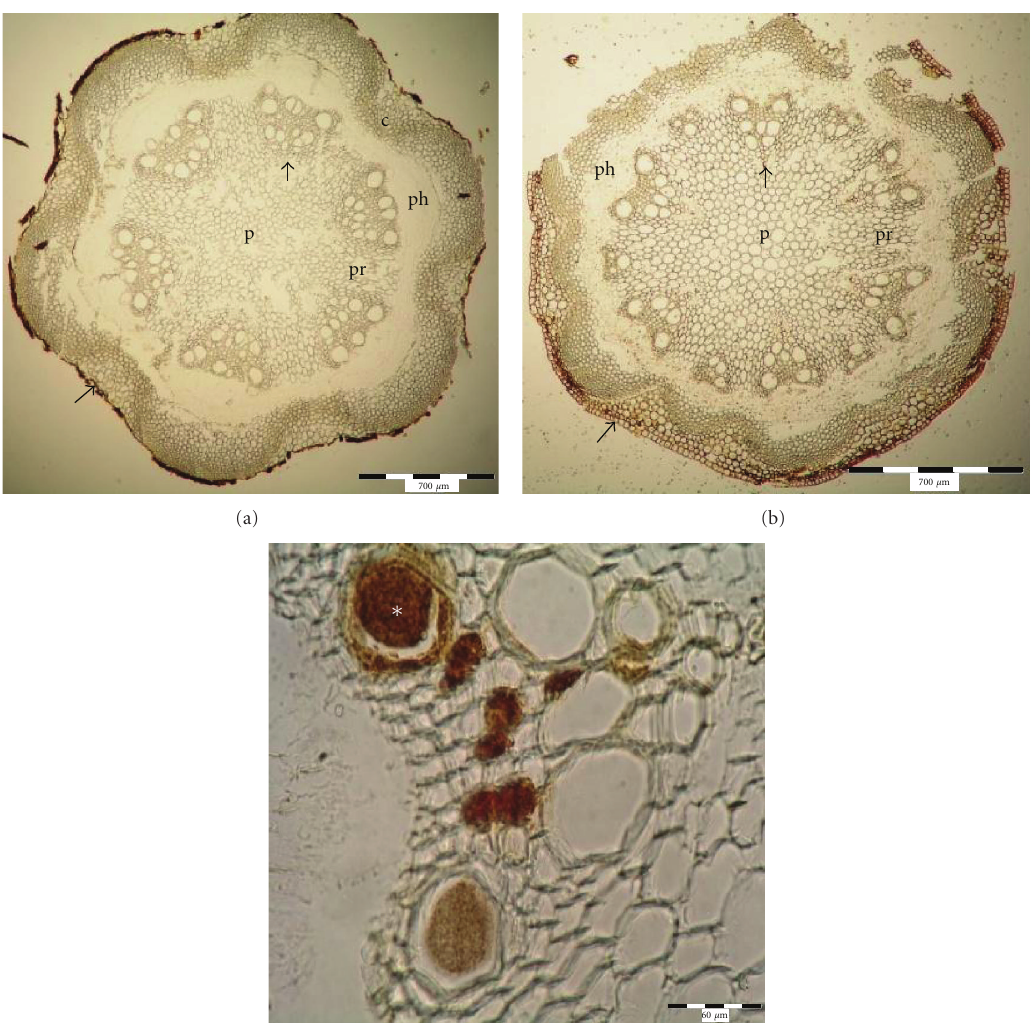
Figure 7: Histochemical identification of suberins in xylem occlusions in stems of Clematis “Solidarno´s´c” by using Sudan IV. (a) Identification of suberins in xylem of control stems; (b) identification of suberins in xylem of stems kept in 8HQC + 2% sucrose; (c) identification of suberins in stems kept in distilled water. P: pith, pr: pith rays, ph: phloem, arrow: xylem vessel, c: cortex with lamellar collenchyma, ∗ : blocked xylem lumen, (cid:10) :